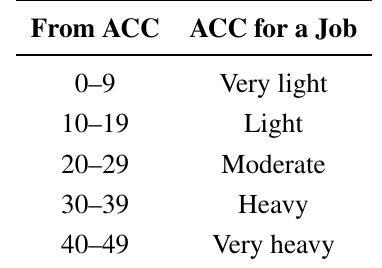
Table 2. Absolute cardiac cost (ACC) values for a